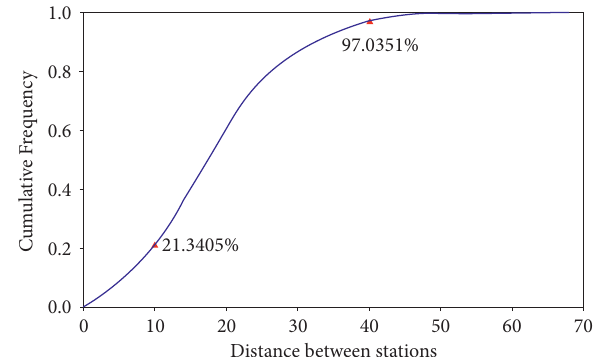
Figure 3: Cumulative distribution curve of the distance between stations.